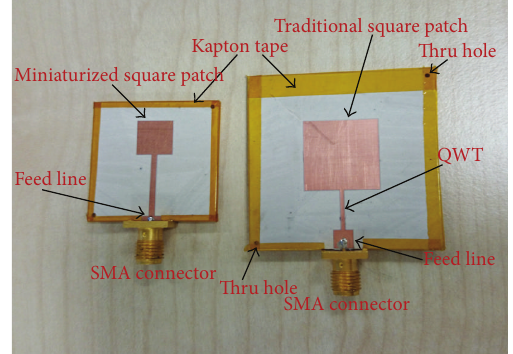
Figure3:Aphotographofthefabricateddesignsoftraditionalpatch with quarter-wave transformer and miniaturized patch with longer feed line.